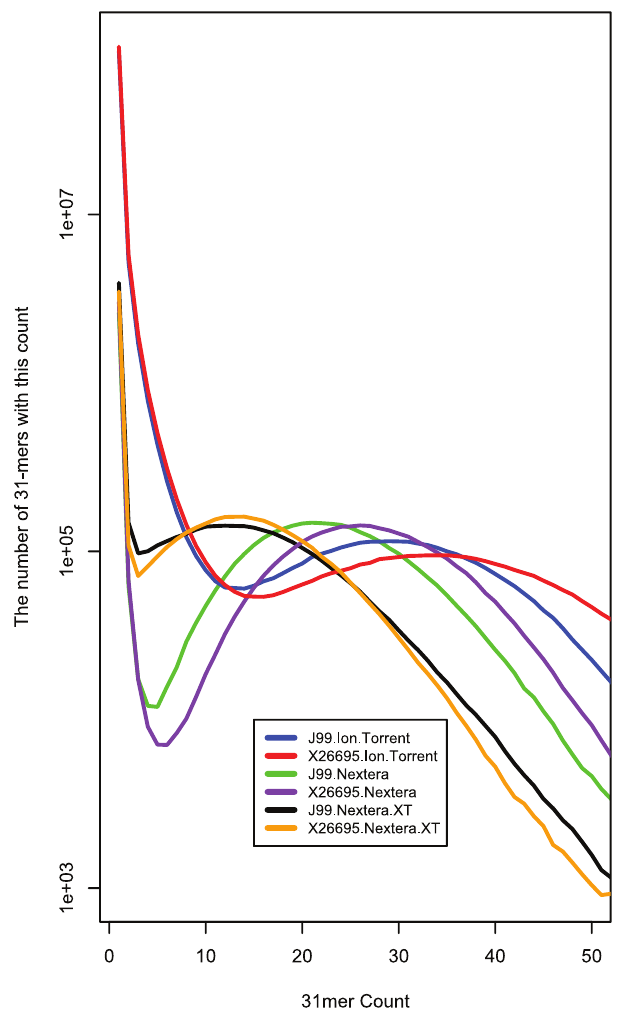
Figure 2. Plot of the frequency of each 31-mer. We determined every possible 31 mer in the sequence data output and then analysed the frequency at which each of those 31-mers occurred. Unique 31- mers are considered sequencing errors given adequate depth. The natural cut-off for each sequencing technology occurs at the turning point in each